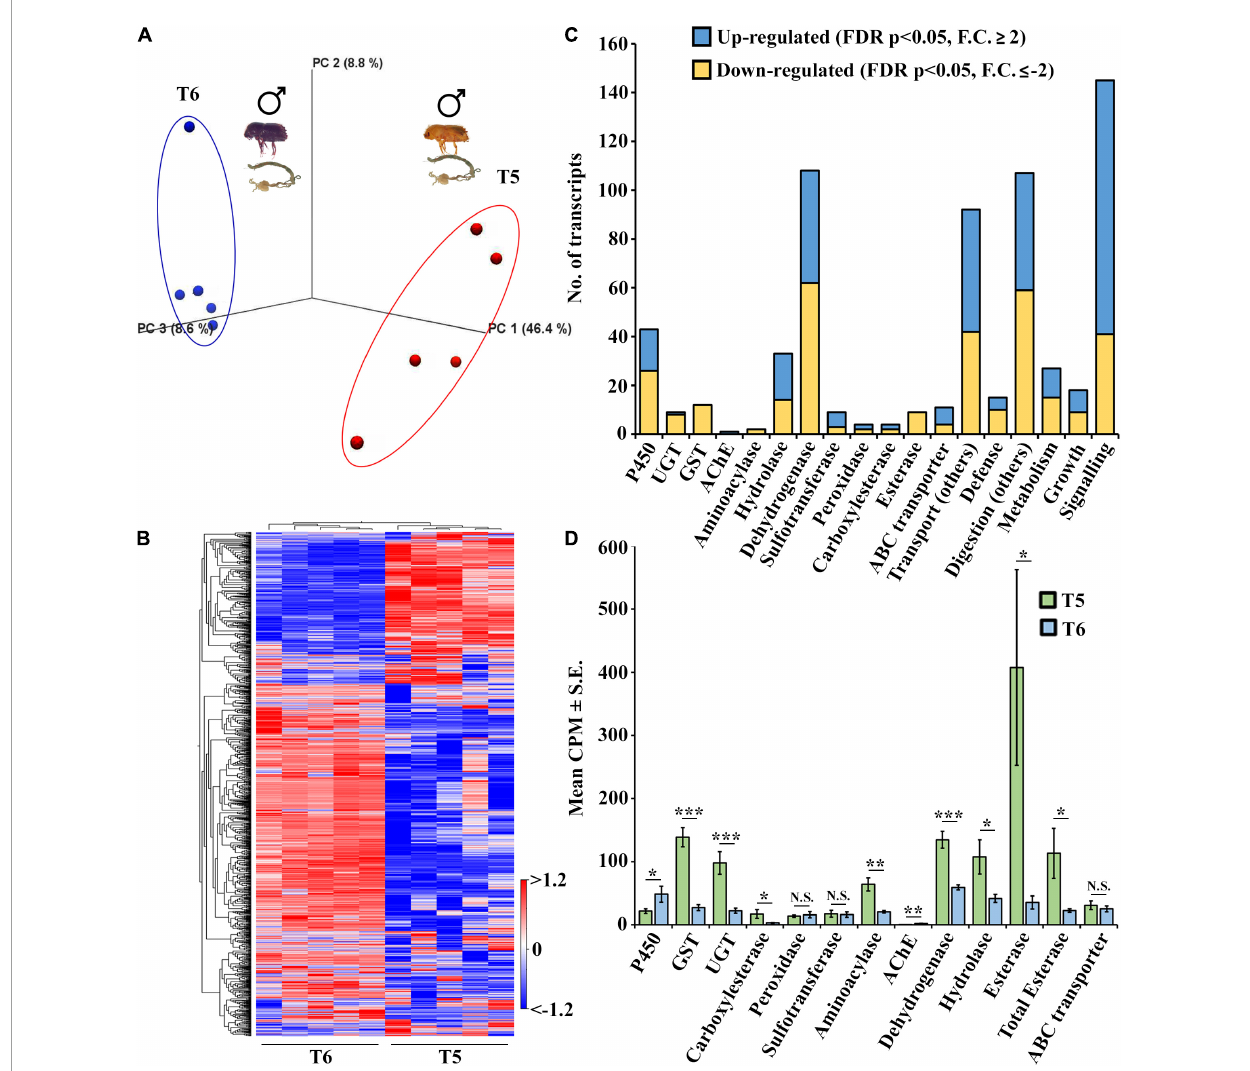
FIGURE8 Comparison between sclerotized male gut (T6) vs. callow male gut (T5) N = 5. (A) PCA plots showing sample clustering. (B) Heat maps representing gene clustering. The color spectrum, stretching from blue to red, represents TMM-adjusted log CPM expression values obtained after DGE analysis. (C) Bar graphs showing the differentially expressed contigs of specific detoxification-related enzyme families and other important enzymes related to defense, digestion, transport, metabolism, signaling, and growth between sclerotized male gut (T6) vs. callow male gut (T5). (D) Detoxification genes expressed as the average of total differentially expressed genes in each family between the sclerotized male vs. the callow guts. Gene families on the x-axis plotted against their corresponding mean CPM values ± S.E. One-tailed T -test was performed to obtain the significant differences between the two stages. * represents p < 0.05, ** represents p < 0.01, *** represents p < 0.001, and NS represents non-significant difference. DGE analysis was done using CLC workbench with FDR p < 0.05 and a fold change ± 2